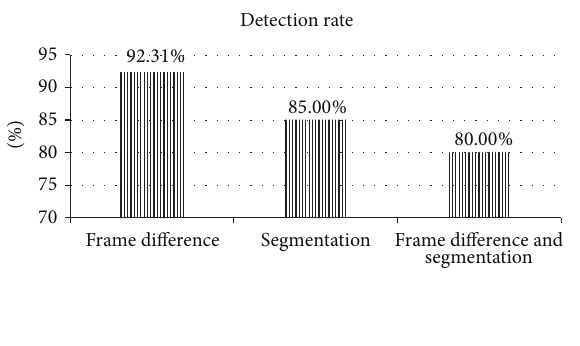
method [8, 13, 38]. Shadow based approach depends on light- ening condition [2, 7, 59]. Region based appearance matching approach does not give the optimum result for crowded scenarios [44, 54]. Histogram oriented gradients (HOG) approach rejects objects backgrounds